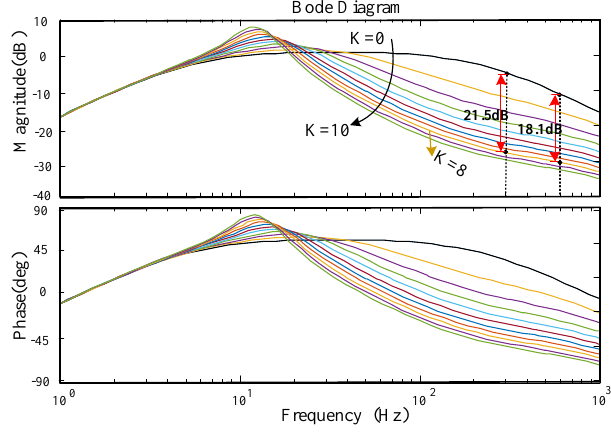
Figure 4. Bode diagrams of H iu (s) with different K .